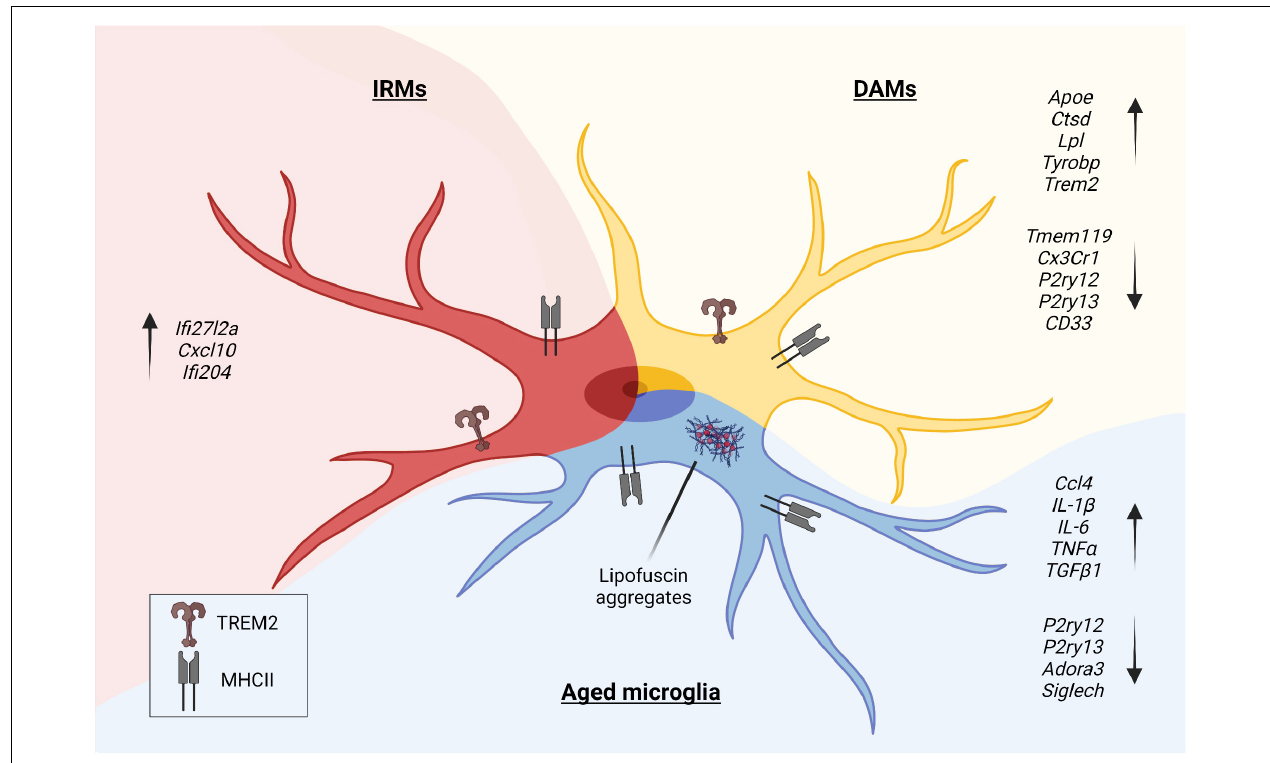
FIGURE 1 | In the pathological context, microglia undergo morphologic and phenotypic changes upon activation. Disease-Associated Microglia (DAMs), Injury-Responsive Microglia (IRMs), and aged microglia represent different activation states, each characterized by a specific transcriptional